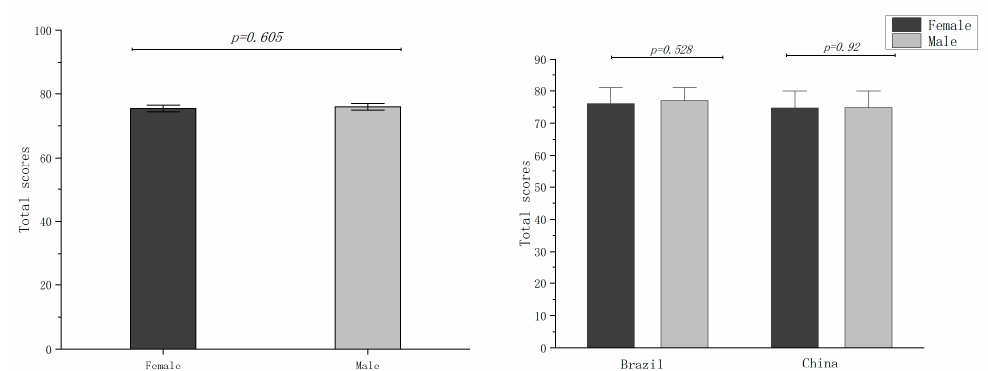
Figure 2. Comparison of total scores between genders.